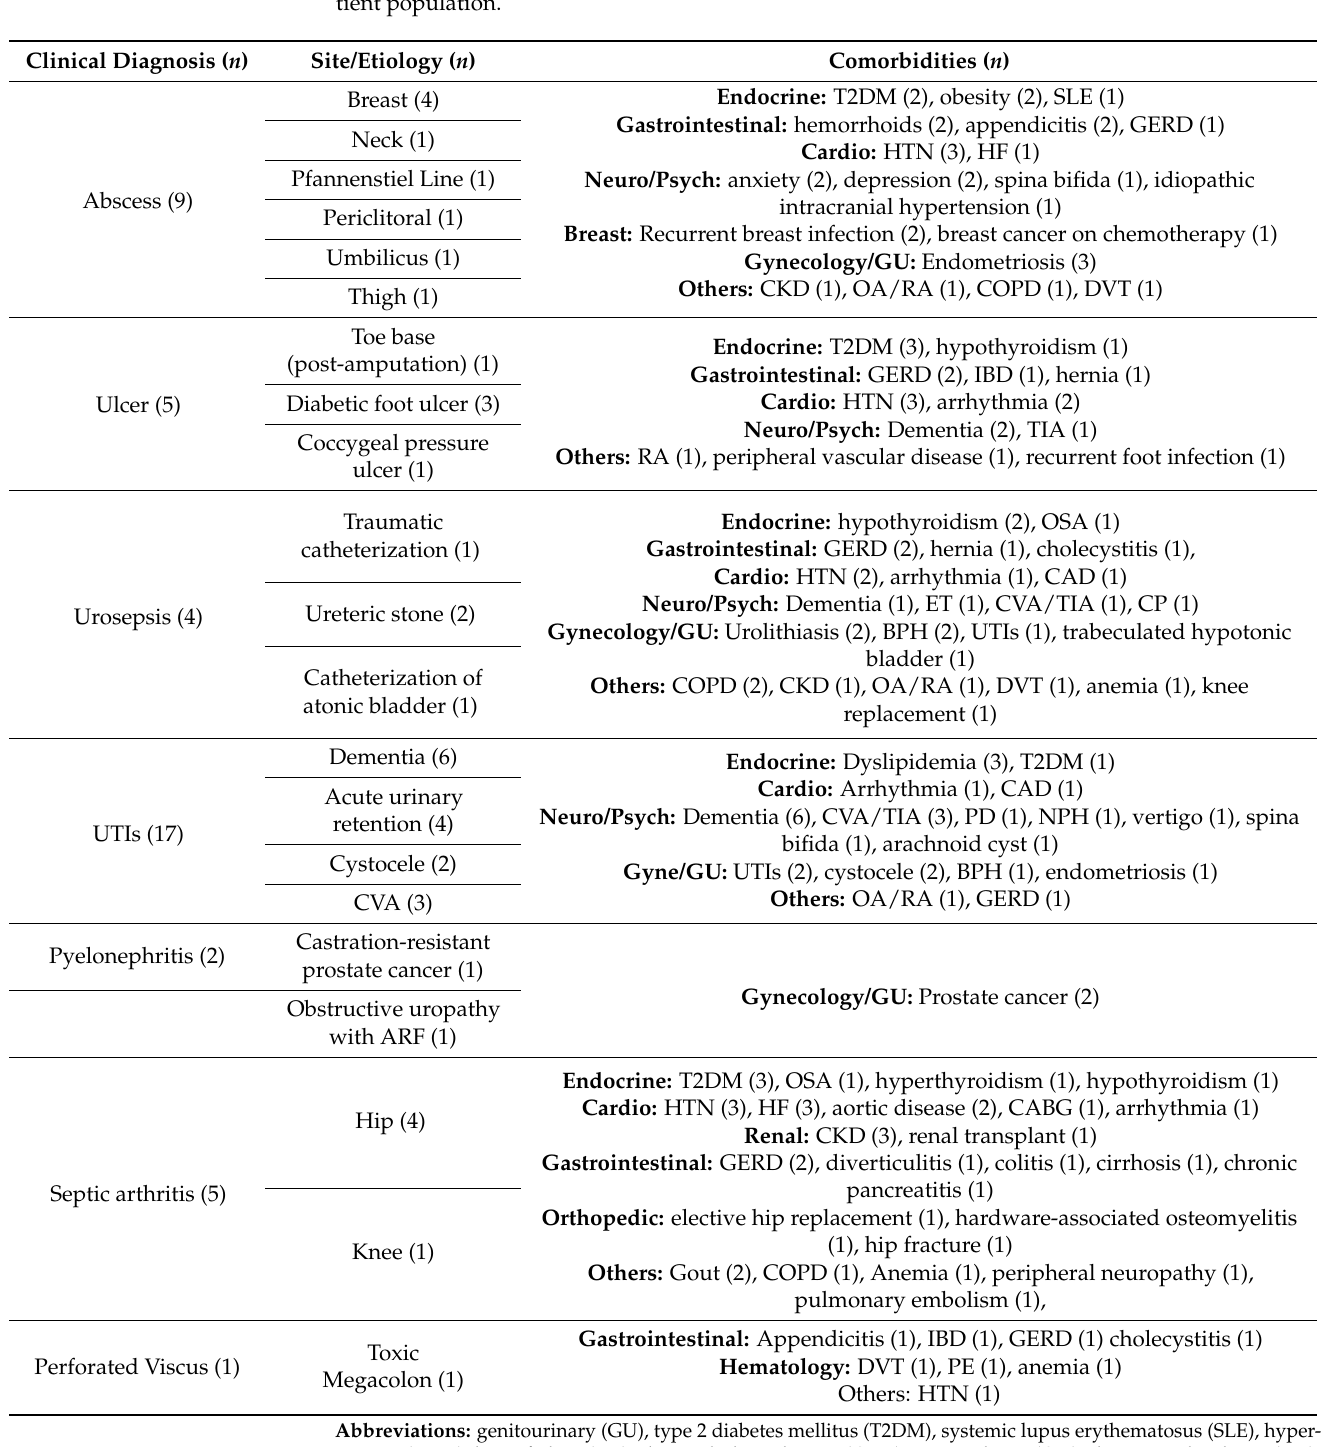
Table 1. Summary of clinical diagnosis, and the medical and surgical comorbidities in the inpa- tient